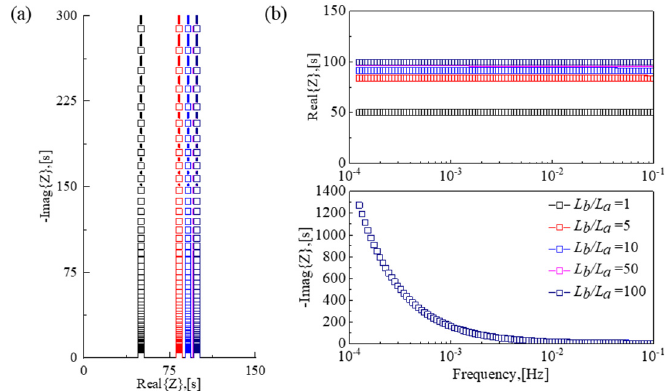
Figure 3. Impedance spectroscopy of different width-to-thickness ratios (Bi = 0.01). ( a ) Nyquist figure, ( b ) variation curve of real part and imaginary part with frequency.